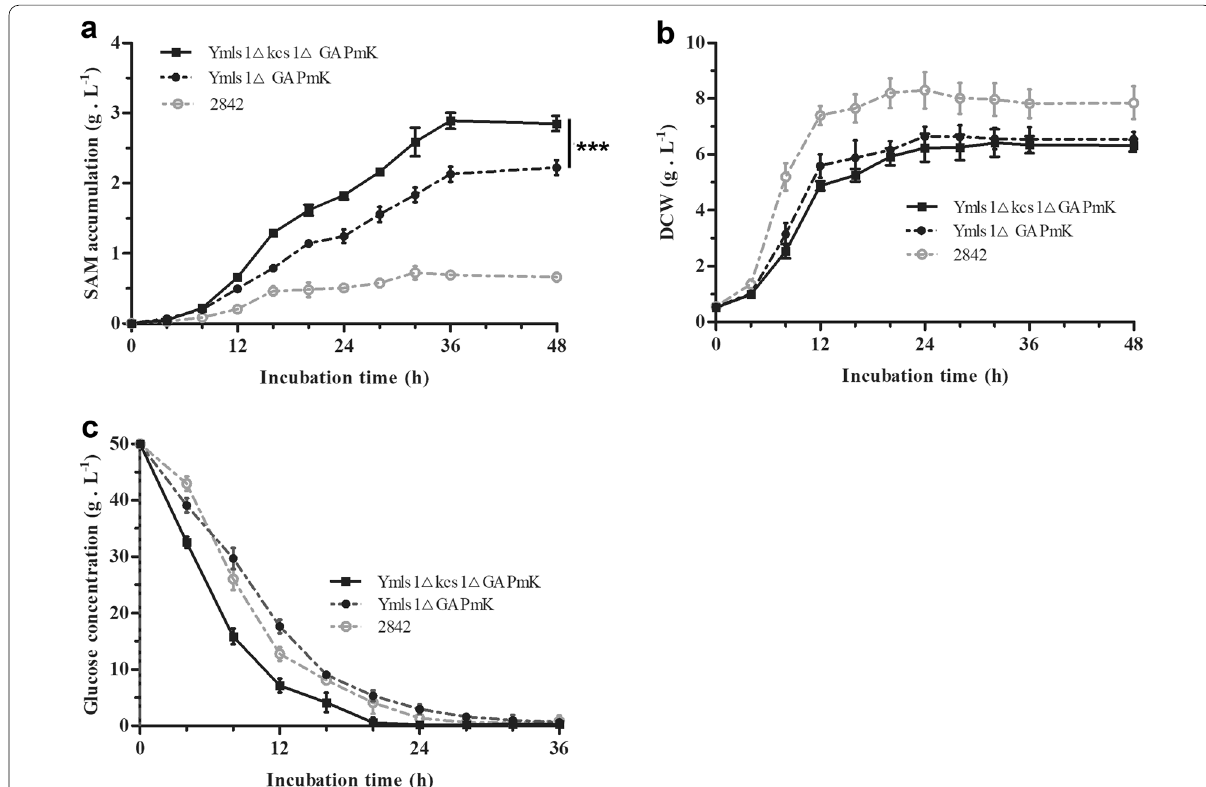
Fig. 6 Increased glycolysis by deletion of kcs1 in the recombinant strain Y mls1 ΔGAPmK further improved SAM production. a The accumulation curve of SAM of the recombinant strain Y mls1 Δ kcs1 ΔGAPmK; b The growth curve of the recombinant strain Y mls1 Δ kcs1 ΔGAPmK; c The glucose uptake rate of the recombinant strain Y mls1 Δ kcs1 ΔGAPmK. Error bars correspond to standard error of mean (SEM) of the biological replicates (n *** denotes significant differences between the recombinant strains Y mls1 Δ kcs1 ΔGAPmK and Y mls1 ΔGAPmK, with p <